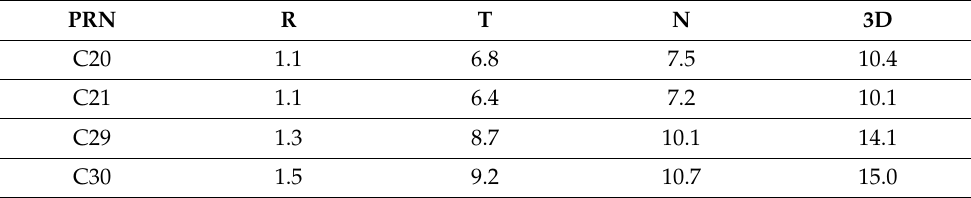
Table 8. The impact of 1 cm systematic error on simulated POD accuracy (unit: Table 7. The impact of 1 cm random error on simulated POD accuracy (unit: cm).